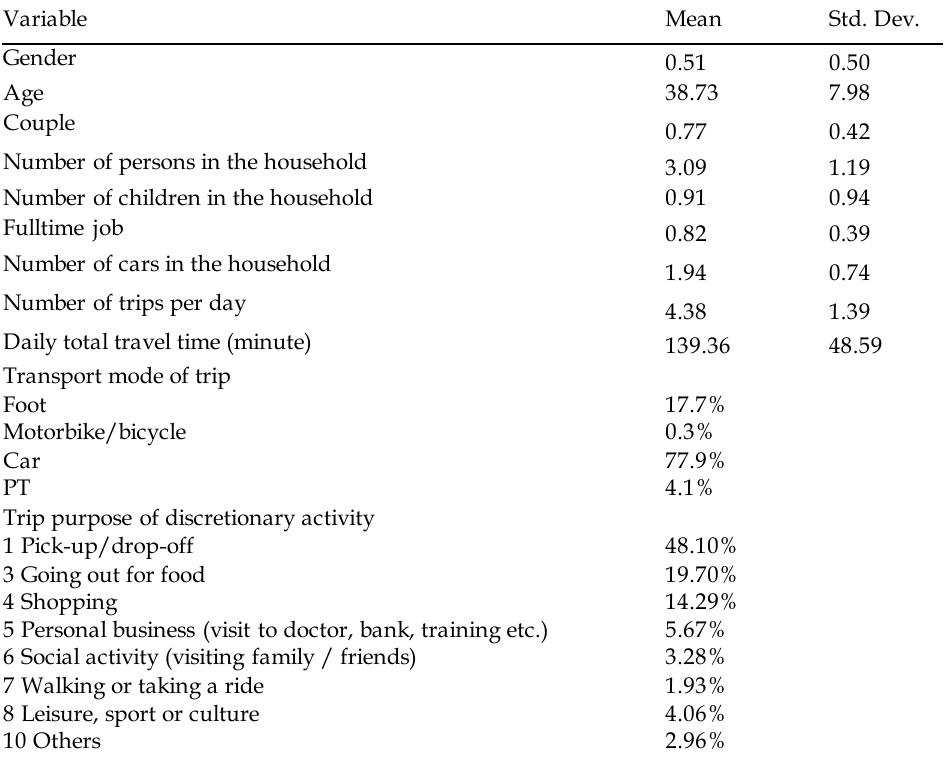
Bayesian networks for constrained location choice modeling using structural restrictions and model averaging Table 1. Descriptive statistics of the